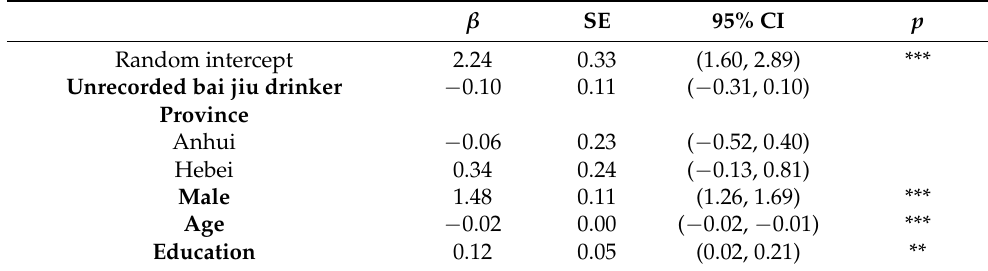
Table 4. Two-level linear regression model of the effect of unrecorded bai jiu drinker and province on the quantity of bai jiu consumed on daily drinking